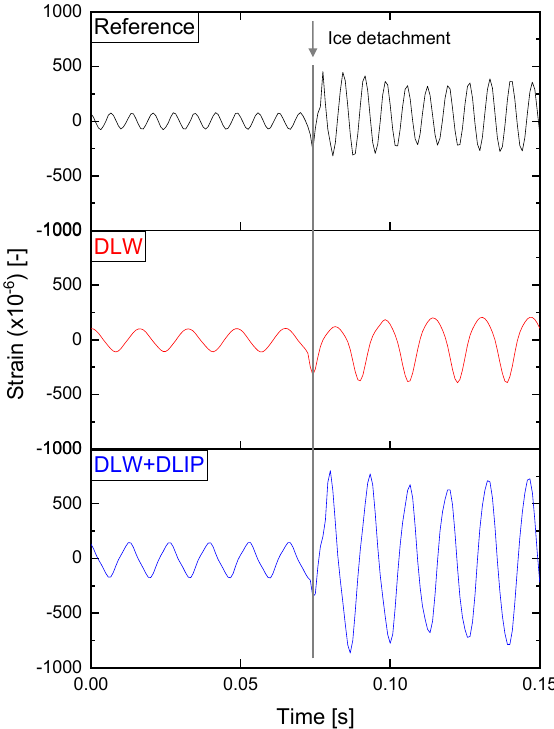
Figure 4. Example of strain gauge readings recorded during the ice adhesion tests for three different samples of an untextured reference AA2024 ( top ), DLW ( middle ), and DLW + DLIP ( bottom ) under test conditions of mixed/rime ice. The time range in which the ice detachment occurred was framed to 0.15 s to obtain a more detailed overview. The amplitude of the strain recorded right before the interfacial crack represented the limit at which the interfacial shear stress matched the adhesion strength of the ice to the surfaces. Exceeding this value triggered a crack at the ice-surface interface. The Euler-Ber- noulli beam theory could be used to correlate the strain to the maximum interfacial shear stress (i.e., ice adhesion) between ice and surface, which is expressed in Equation (1) [45]: (cid:2013) (cid:3006)(cid:3007)(cid:2879)(cid:3028)(cid:3039) (cid:1831) (cid:3036)(cid:3030)(cid:3032) (ℎ (cid:3036)(cid:3030)(cid:3032)(cid:2870) + 2ℎ (cid:3036)(cid:3030)(cid:3032) |(cid:1857)|) (cid:2028) (cid:3036)(cid:3041)(cid:3047) = 2((cid:1876) − (cid:1864))(ℎ (cid:3030)(cid:3039) − |(cid:1857)|)